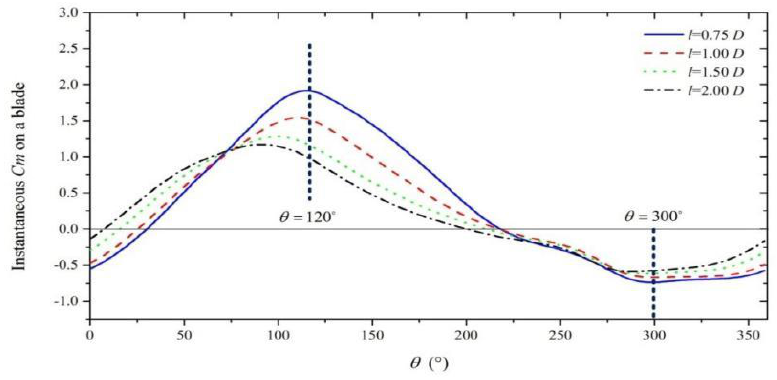
Figure 10. The power performance of turbines at different gaps.